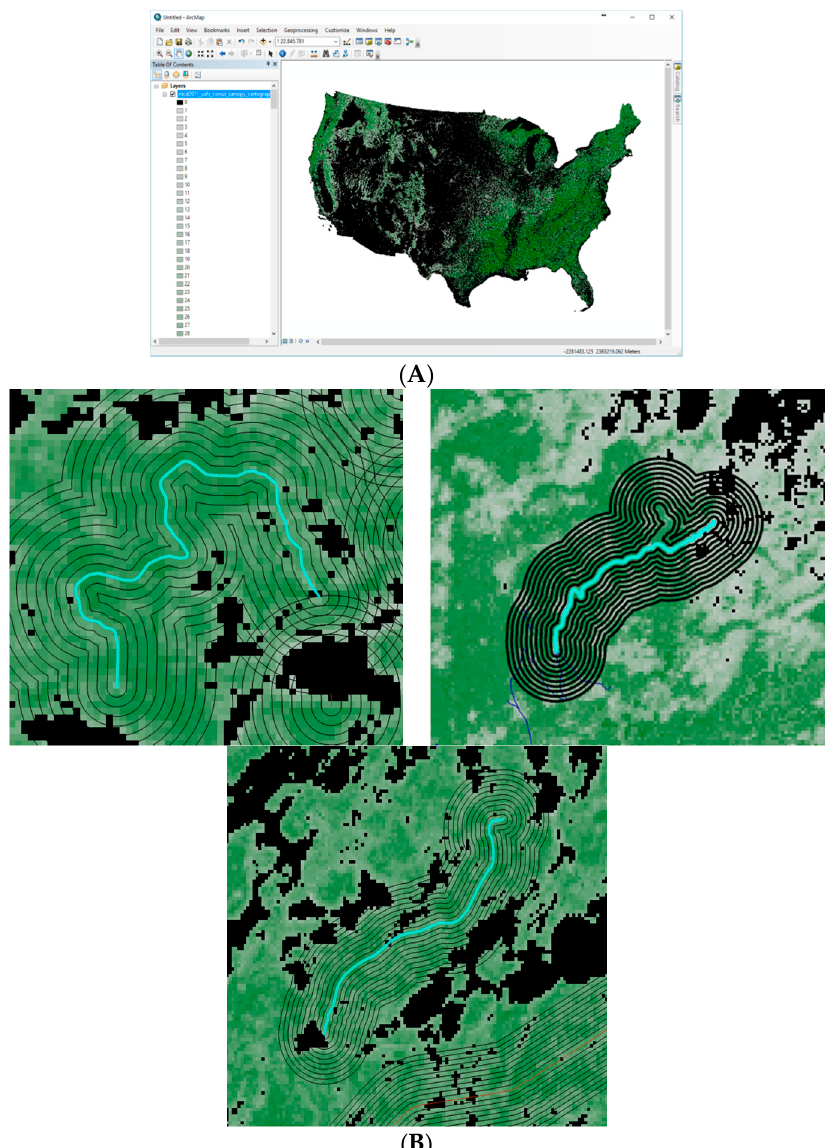
Figure 1. Tree canopy across the US ( A ). Tree canopy coverage surrounding forest trails ( B ). The light blue-green line is the actual trail. The surrounding black rings around the trail represent increasing distances from the trail center, 45 m apart. The green map layout represents canopy coverage per location, image pixel—30 m 2 , calculated based on satellite imagery. The darker the shade of green, the greater the canopy coverage is. For each ring extending the distance around the trail, the average green shading was calculated. Black areas in the map represent areas where no canopy was identified, such as bodies of water and cliffs. The overlapping influence of effects from nearby trails was also analyzed, as can be seen from other coinciding rings from other trails.